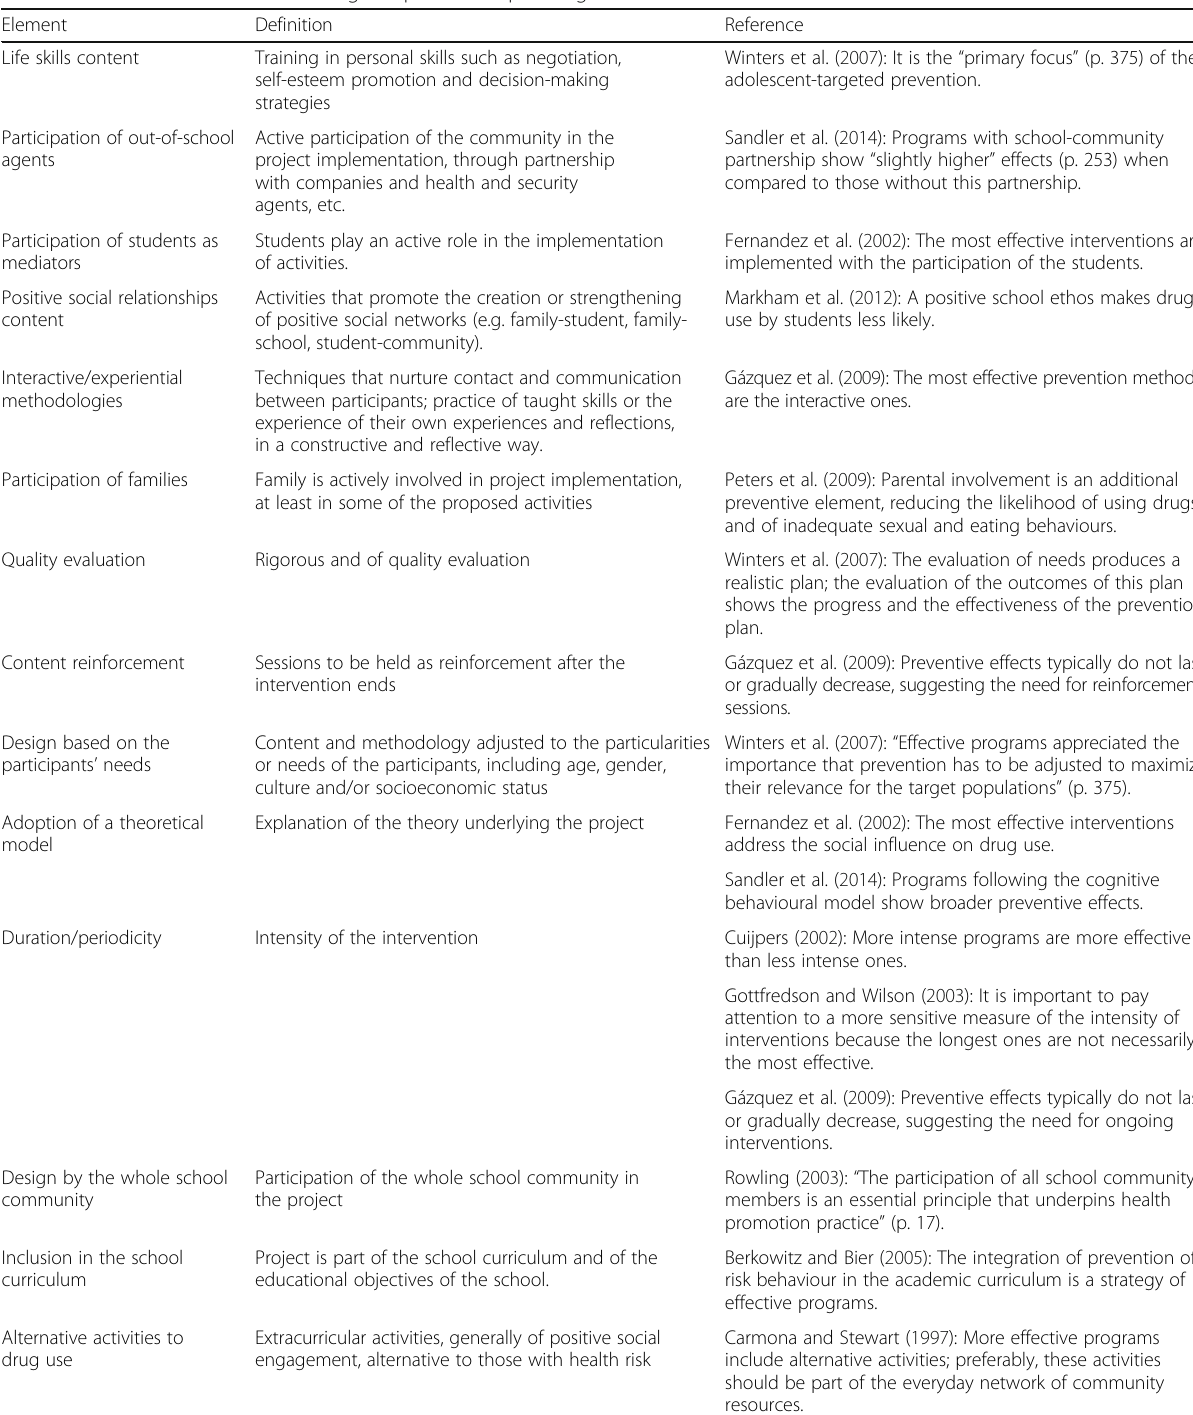
Table 1 Effectiveness elements of drug use prevention planning at